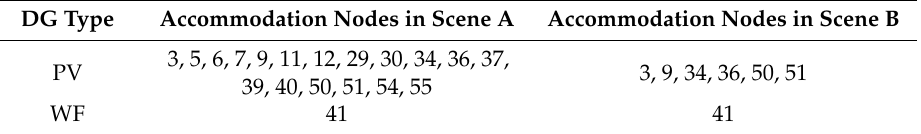
Table 1. The configuration scenes of DG connection nodes.